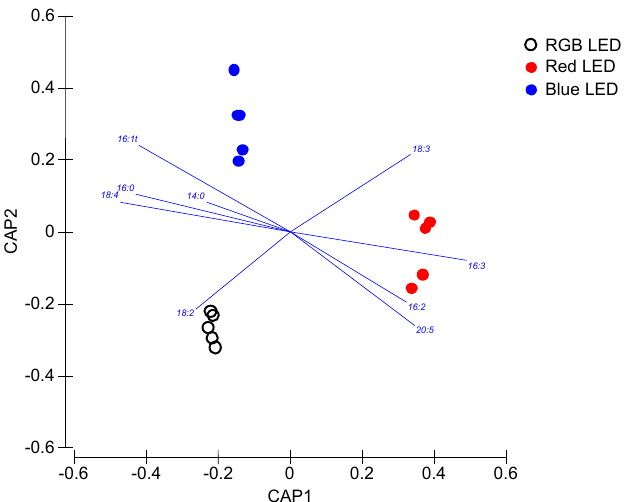
Figure 8. Canonical Analysis of Principal (CAP) components of the P. tricornutum cultures ( N = 5) subjected to the three light treatments, having as basis the total fatty acid profile (relative concentrations) at the end of the 96 h exposure period (93.3% classification efficiency).